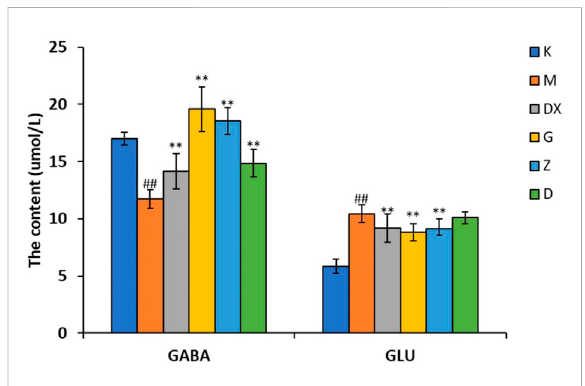
FIGURE 7 Effects of R-S on GAD65 and GS content in rats with